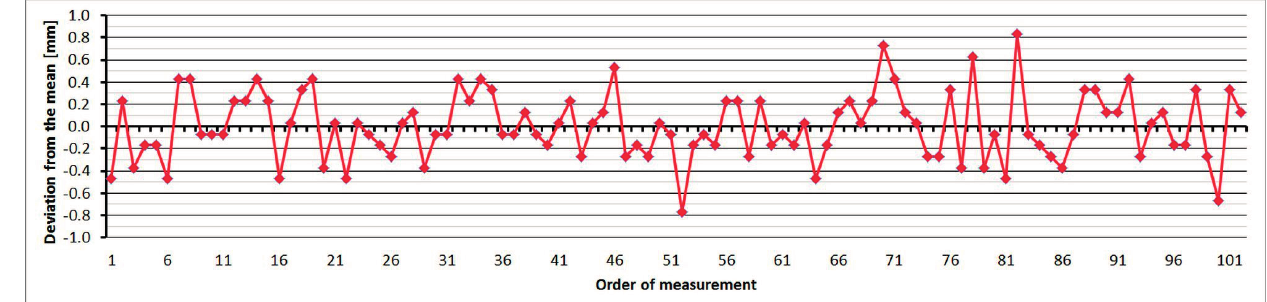
Figure 9. Trimble S6 HP–Differences from average distance–pillar 7 (13.9 m).